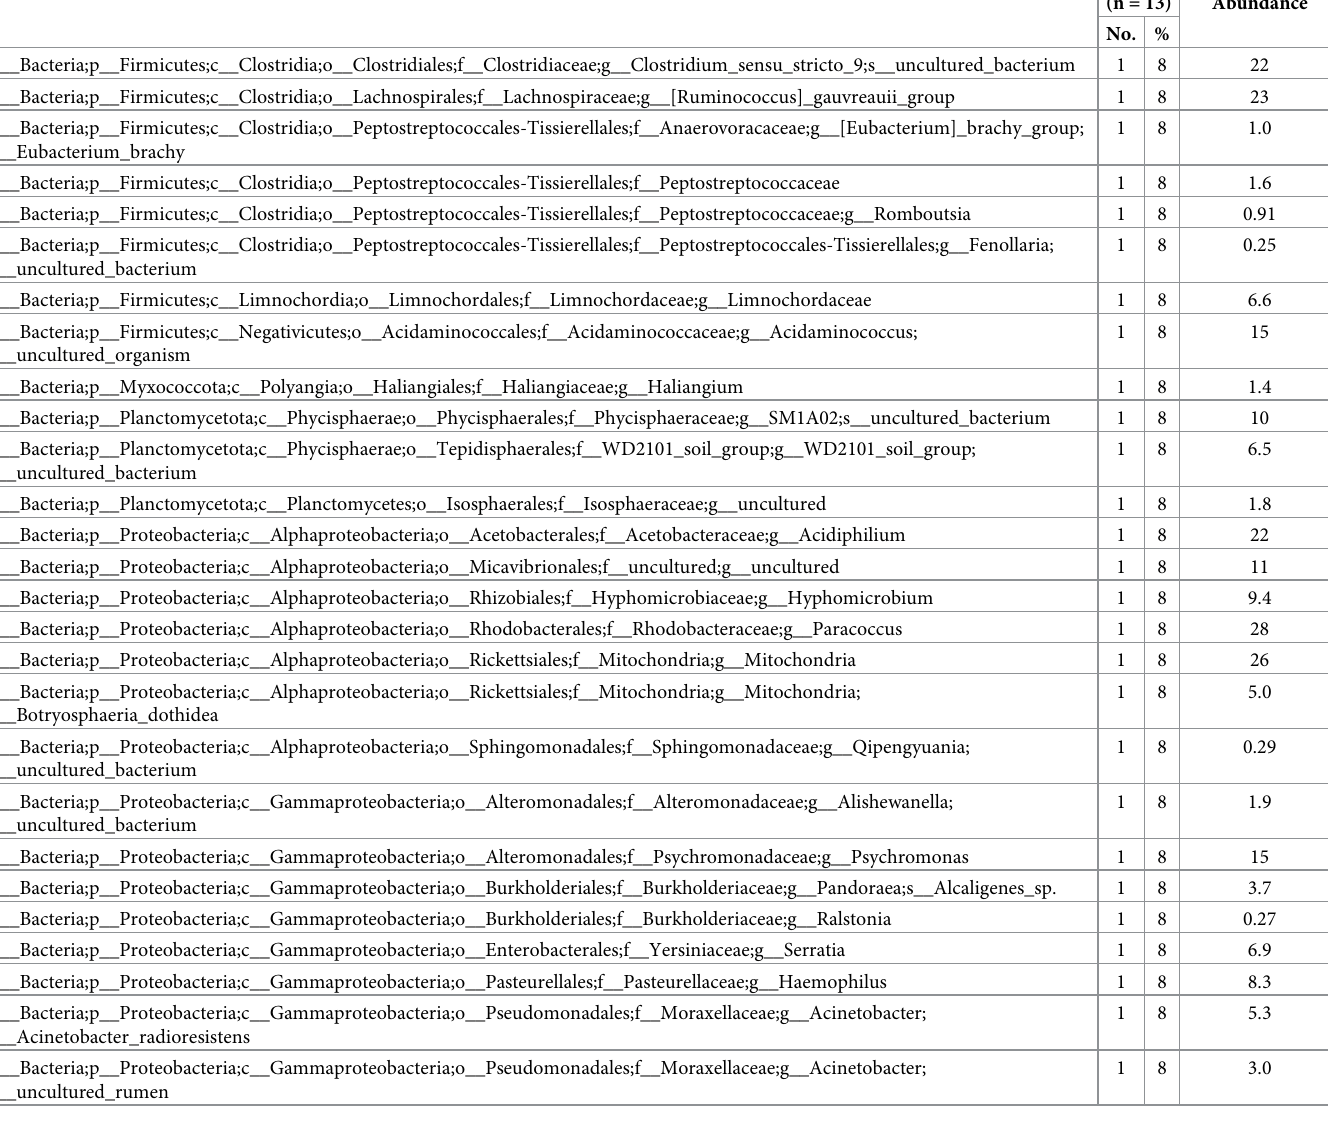
Conventional detection of bacteria. Bacteria were not identified by cytological exami- nation in any control dog bile samples. Yeast organisms were observed in 2 control bile samples (sample 7 and 19). Bacterial growth was not observed in any control dog bile sam- ples under either aerobic or anaerobic culture conditions. Histological examination of the gallbladder was performed in all control dogs, all of which appeared unremarkable and none of which had eubacteria identified by FISH. Combining cytology, conventional cul- ture, and FISH, the presence of bacteria was demonstrated in samples from 0/13 (0%) con- trol